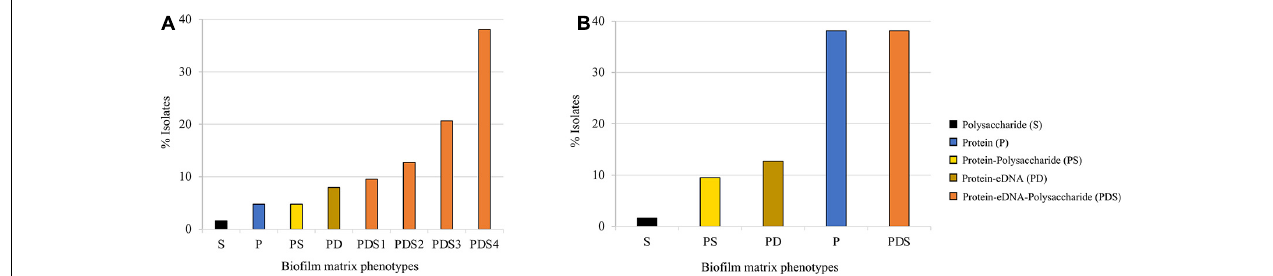
FIGURE 1 | Quantitative classification of preformed biofilm in 63 Staphylococcus saprophyticus strains based on matrix phenotypes. (A) Activity of biofilm-degrading agents, namely, proteinase K, DNase, and sodium periodate, was assessed on biofilm produced. Isolates with > 70% biofilm reduction after treatment with specific biofilm detaching agents were interpreted to be composed of the component targeted by the disruptor, while 30–70% or < 30% biofilm reduction after disruption were expressed as partially composed or not composed of the targeted biofilm components, respectively. S, polysaccharide; P, protein; PS, protein–polysaccharide; PD, protein–partial eDNA; PDS1, protein–polysaccharide–partial eDNA; PDS2, protein–partial polysaccharide–eDNA; PDS3, protein–eDNA–partial polysaccharide; and PDS4, protein–polysaccharide–eDNA. (B) Biofilm matrix phenotypes were categorized based on the major component such that components that were partially present (30–70% biofilm detached) in the biofilm produced by isolates were excluded. S, polysaccharide; PS, protein–polysaccharide; PD, protein–partial eDNA; P, protein; and PDS, protein–polysaccharide–eDNA. Assays were carried out in triplicates. All assays were carried out in triplicates.